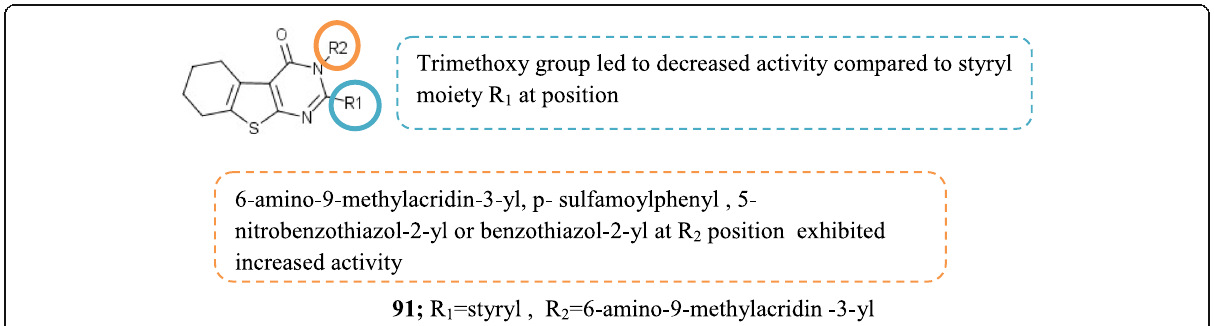
Fig. 31 SAR studies and chemical structures of 2,3-disubstituted-4-oxo-5,6,7,8-tetrahydrobenzo [4,5]thieno[2,3-d]pyrimidines